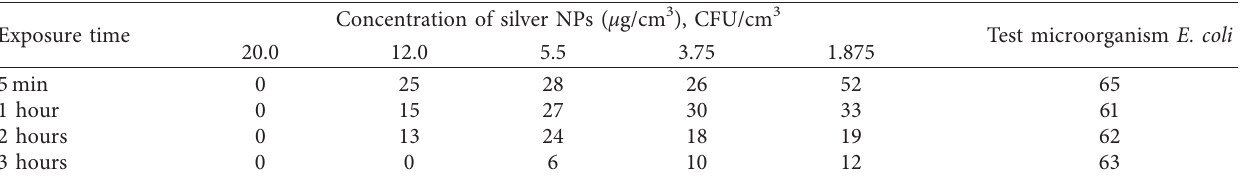
Table 2: Determination of the antimicrobial activity of a solution of nanoparticles against the test microorganism E. coli with the help of the suspension method.